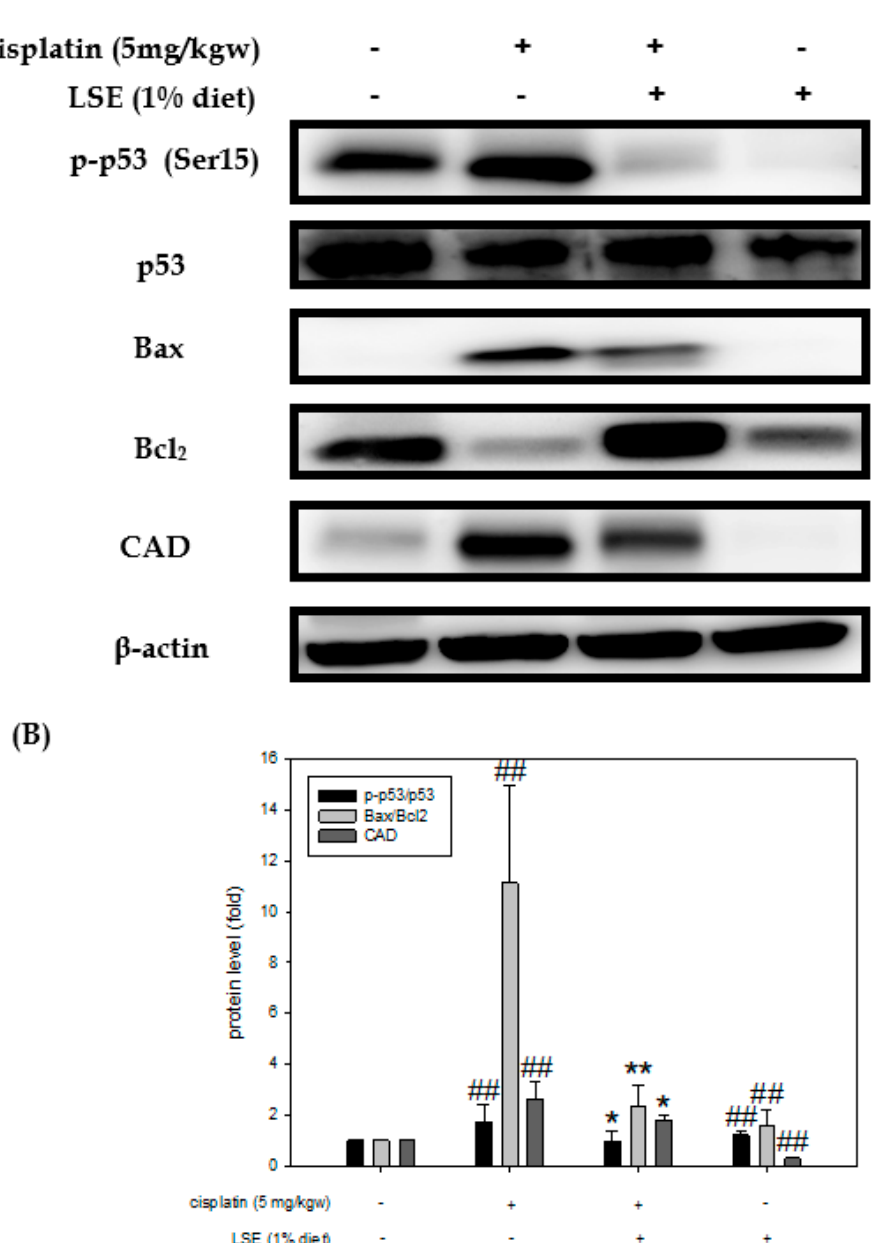
Figure 7. Effect of LSE on kidney expression of apoptosis-related proteins in nude mice induced by cisplatin treatment. ( A ) The protein levels of p53, p -p53, Bax, Bcl2, and CAD were analyzed by West- ern blotting. ( B ) Quantification data were presented as mean ± SD of three independent experiments by using Sigma plot 10.0 software. ## p < 0.01 compared with the control group; * p < 0.05, ** p < 0.01 compared with the cisplatin group.